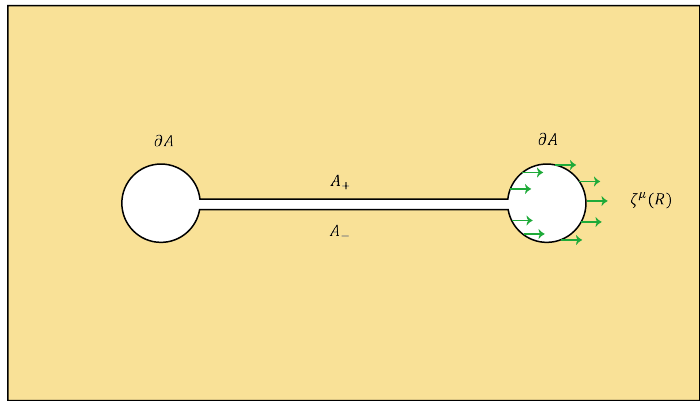
Figure 3 . The UV-cut surface at the ∂A of the single interval ( − R, R ) in 2D CFT. For the deformation vector field ζ ( x ) , we only show its restriction on ∂A which is relevant for our